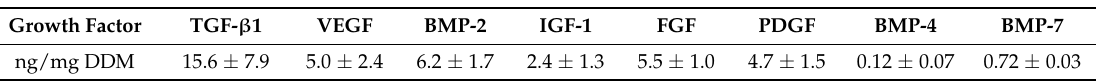
Table 1. Quantification of growth factors in demineralized dentin matrix (DDM) detected by enzyme-linked immunosorbent assay (ELISA).